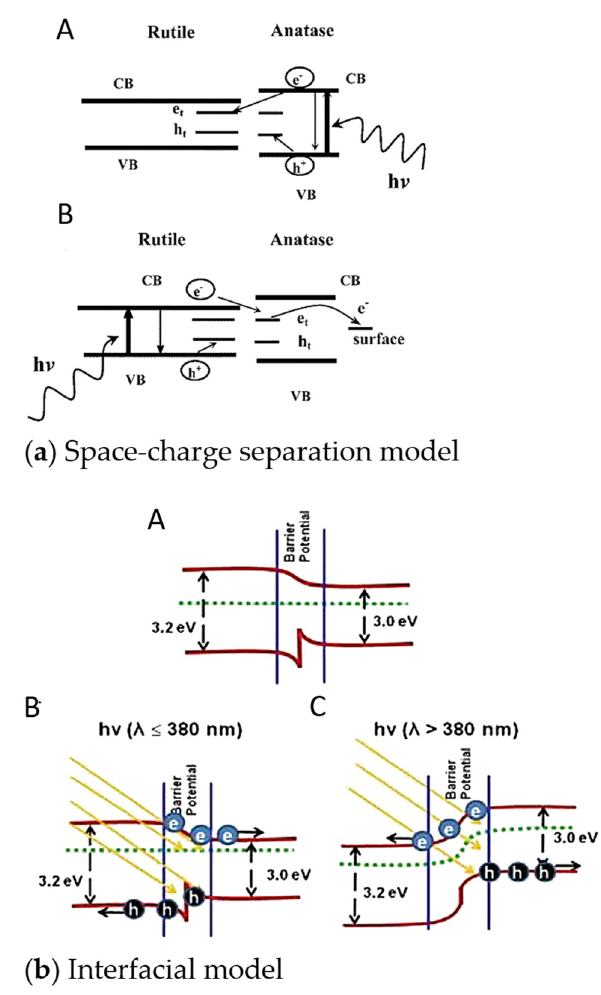
Figure 5. Models describing the mixed phase synergistic effect due to heterojunction formation: ( a ) space-charge separation model in which the transfer of electron can occur from (A) anatase to rutile or (B) rutile to anatase. Reprinted (adapted) with permission from Hurum, D.C., et al. Copyright 2003 American Chemical Society [163]; ( b ) Interfacial model which describes the band bending at the interface of anatase and rutile (A) at equilibrium, (B) when irradiated with light of wavelength ≤ 380 nm, and (C) when irradiated with >380 nm. Adapted and reprinted with permission from ref. [164]. Copyright 2011 Elsevier B.V.